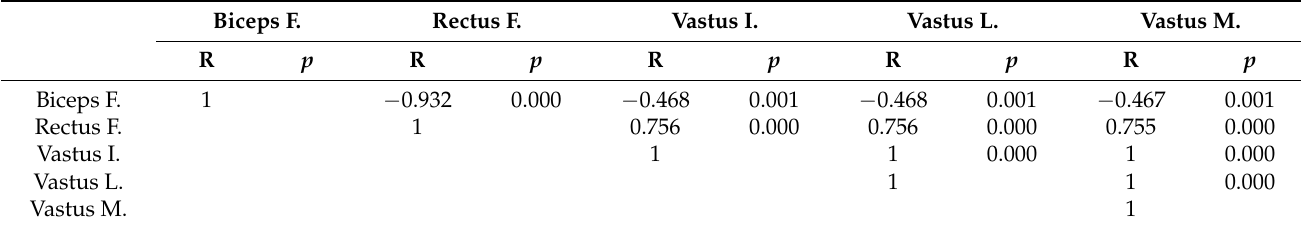
Table 1. Correlation of thigh